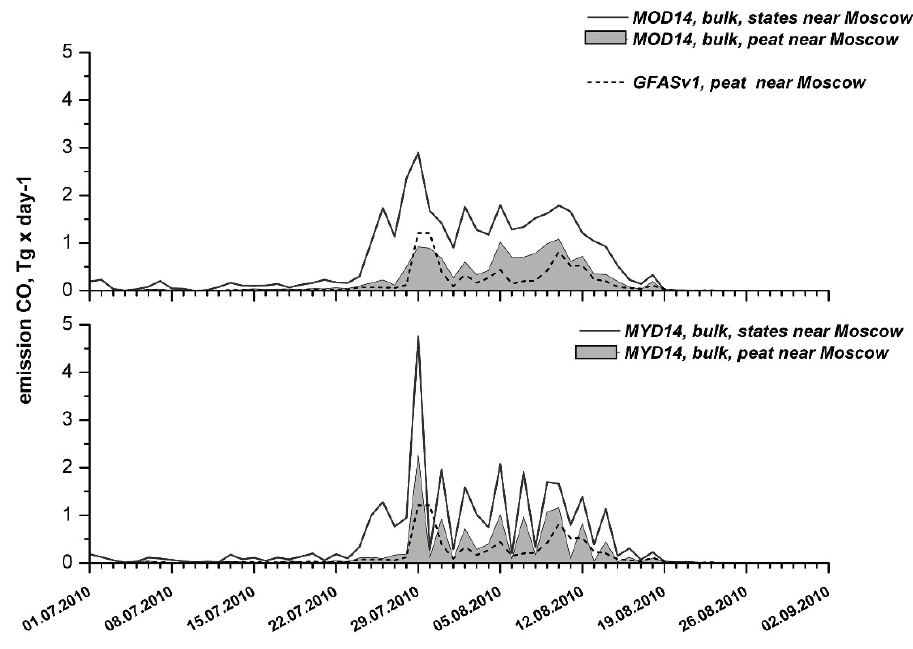
Figure 13. Daily CO emissions from wildfires in the central part of Russian plain and peat areas (grey background color) between 1 July and 1 September, 2010. The emission values were calculated by “bulk method” (Equation (1)) with ignition localization by MOD14/MYD14 data. The GFASv1 emission values in peat area have been shown as dash line in the figure for